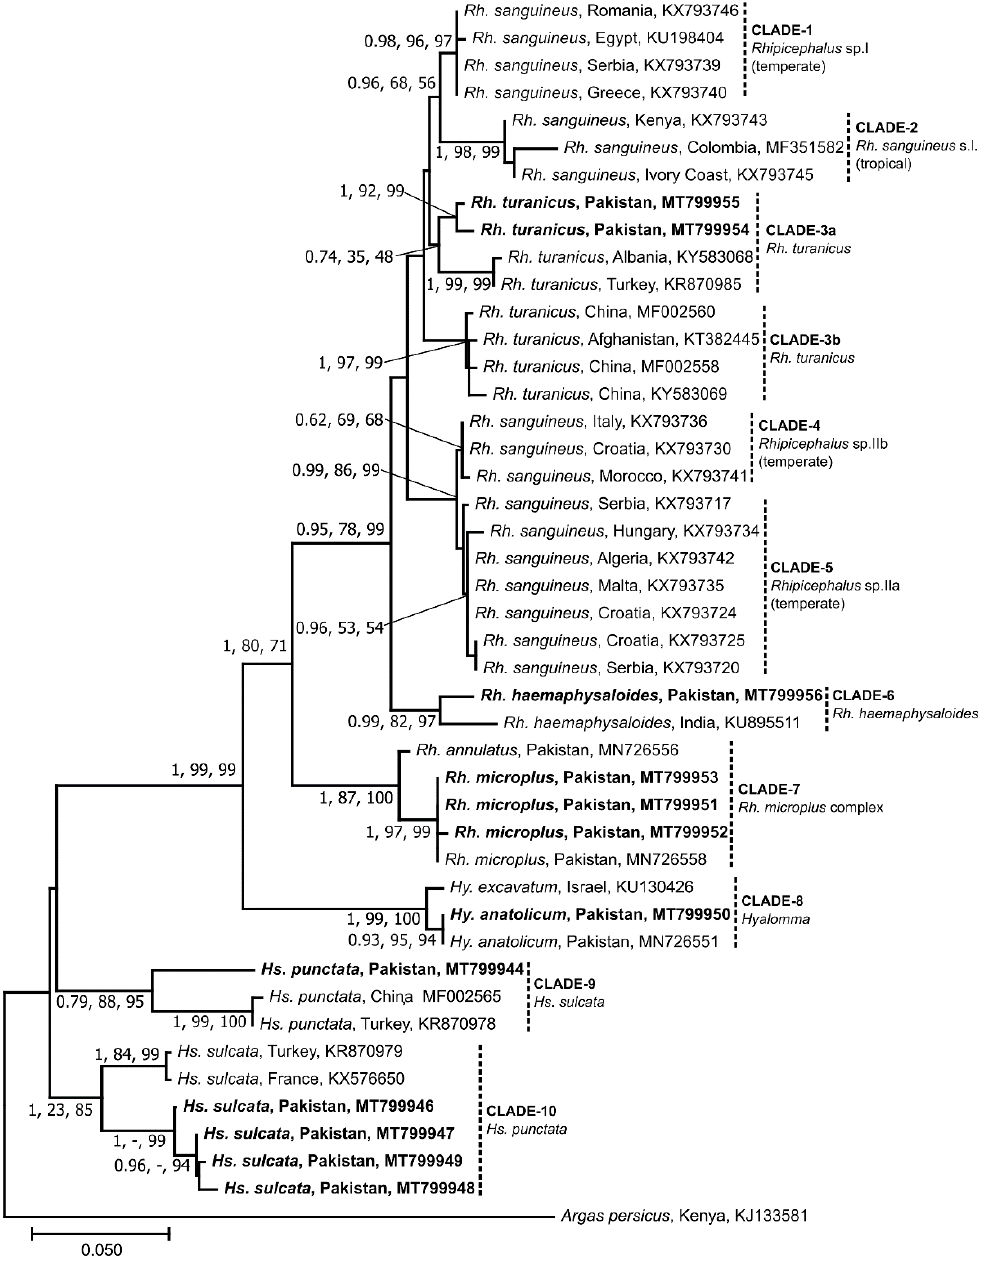
Figure 2. Phylogenetic relationships of partial 16S rRNA sequences of ticks collected from small ruminants in the FATA of Pakistan. Phylogenies were inferred using Neighbor Joining (NJ, this tree), Maximum Likelihood (ML) and Bayesian Inference (BI) methods. Sequences determined herein are shown in bold. The country of origin and GenBank accession numbers for each sequence are also provided. Nodal support values are presented as a posterior probability for BI (left) followed by bootstrap values for ML and NJ. The scale-bar indicates the number of inferred substitutions per